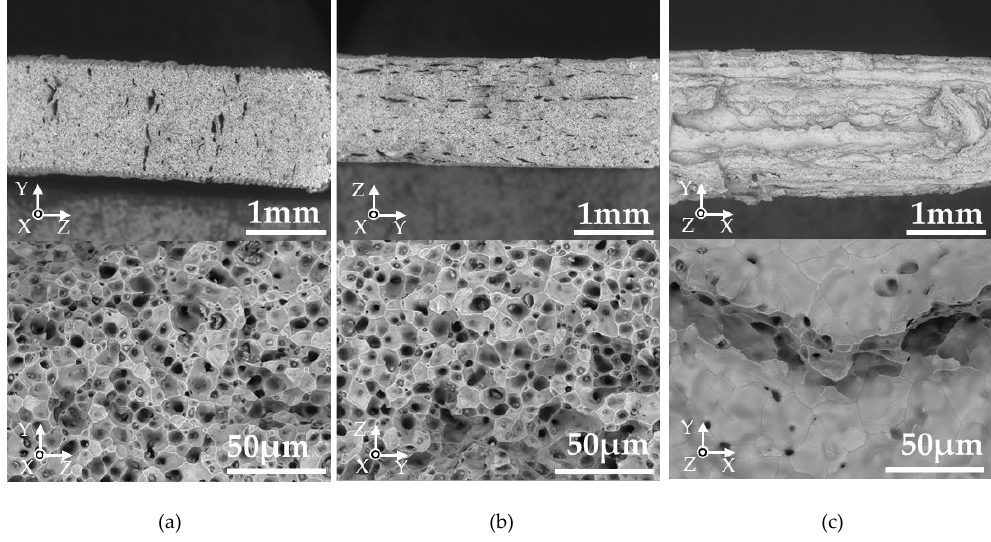
Figure 7. SEM micrographs of fracture surfaces after tensile tests of the silver parts printed in a layer thicknesses in 0.1 mm. Specimens are ( a ) W-specimen, ( b ) T-specimen, and ( c ) L-specimen (the micrographs below are observed in higher magnification).